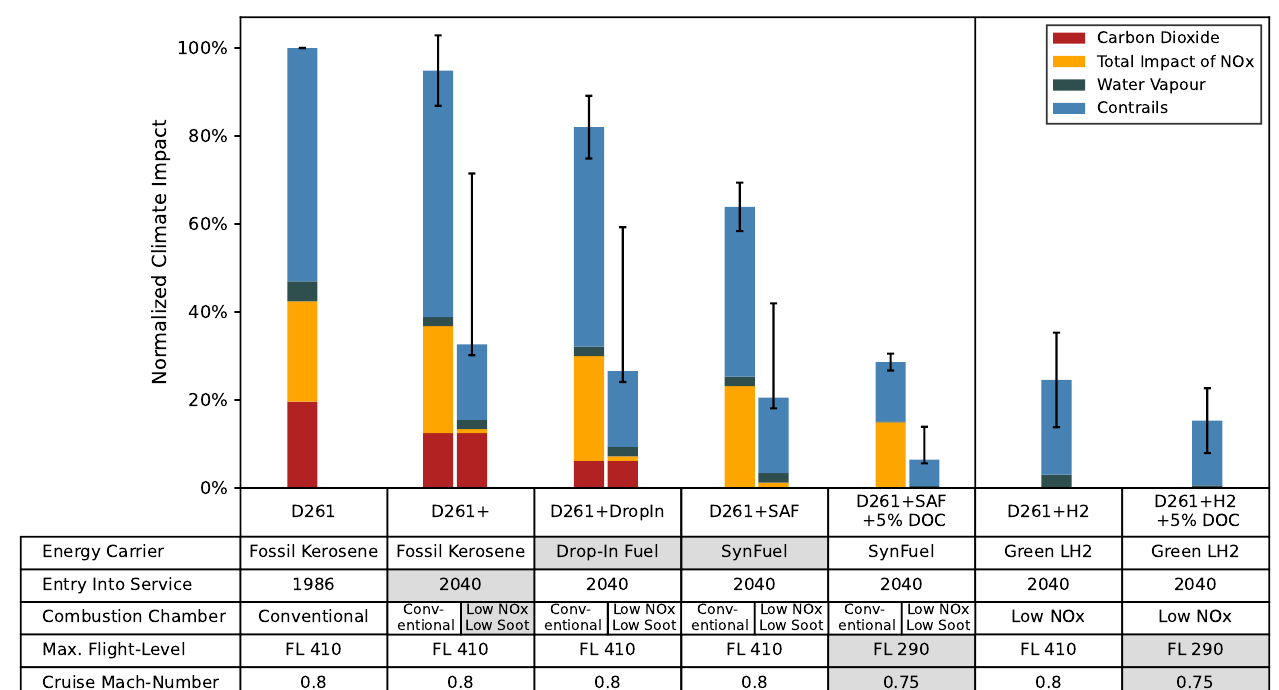
Figure 16. Relative change in climate impact (ATR100) with conventional and advanced low-NO x and low-soot combustion. The grey cells indicate the changes of the new scenario compared with the preceding neighbour. The uncertainties are visualized by the black whisker